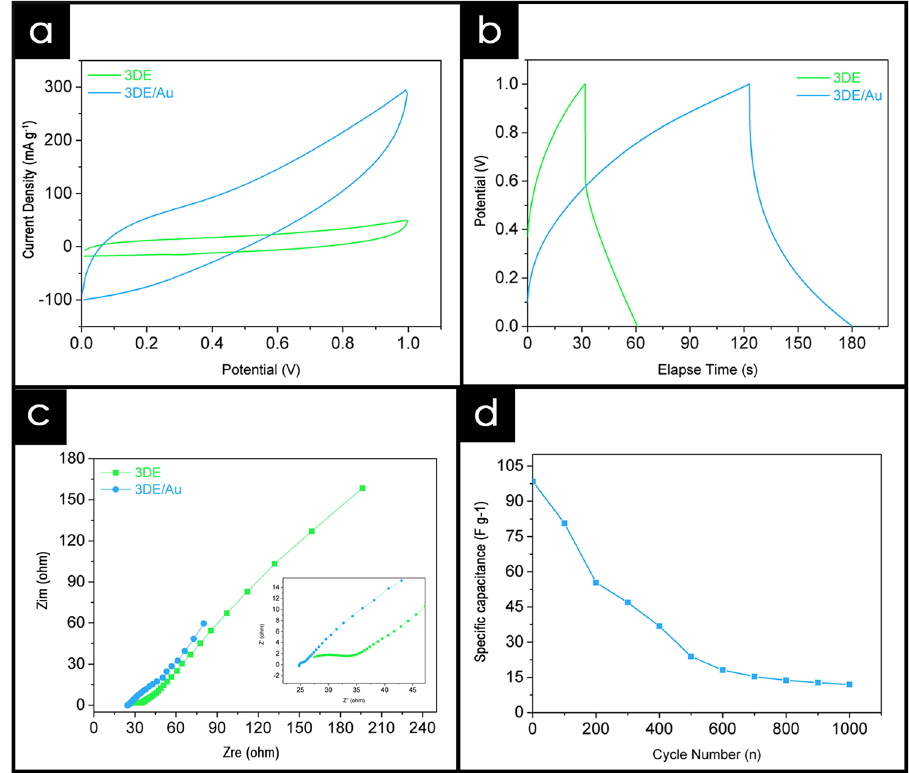
Figure 4. Electrochemical performance of 3DE/Au-based supercapacitor. ( a ) Cyclic voltammogram analysis over 1.0 V potential range at scan rate of 50 mV s − 1 , ( b ) corresponding galvanostatic charge/discharge profile at current density of 0.5 Ag − 1 , ( c ) Nyquist plot, and ( d ) cyclic stability profile of as-fabricated